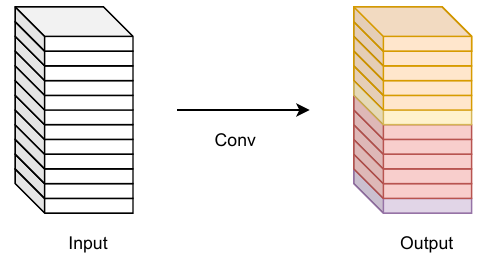
Figure 4. The normal convolution.